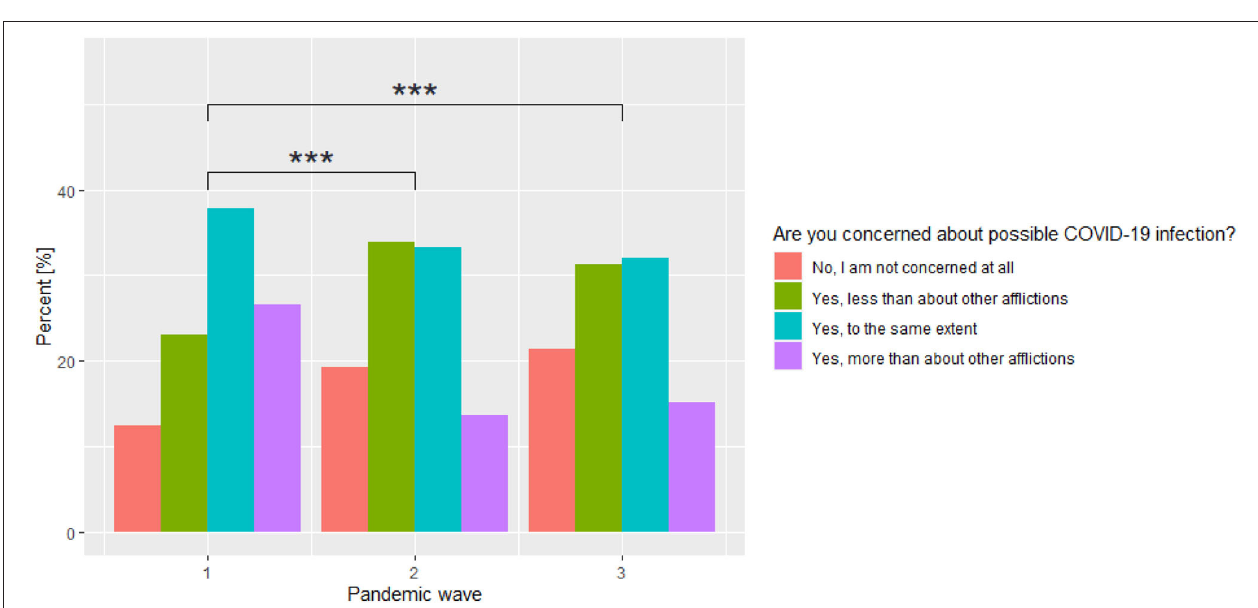
FIGURE 3 | Comparison of the percentage of individuals who are concerned about COVID-19 infection across the three waves of the COVID-19 pandemic. *** p < 0.001.